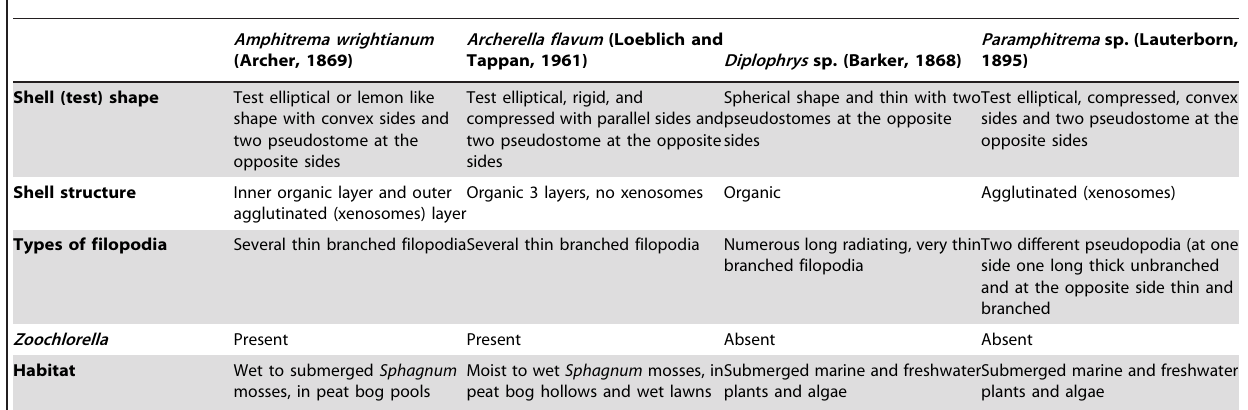
Table 1. General characteristics of the four genera of Amphitremida.